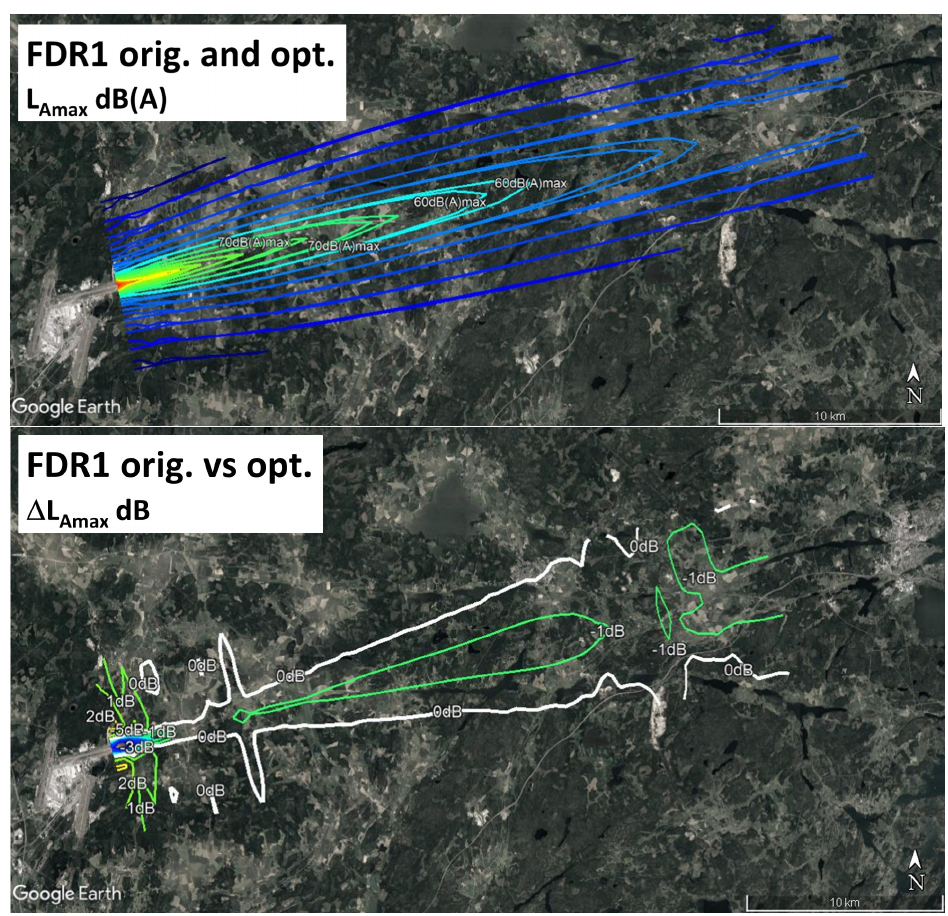
Figure 20. FDR1 original and optimized L Amax noise contours. Superimposed absolute levels ( top ) and level differences ( bottom